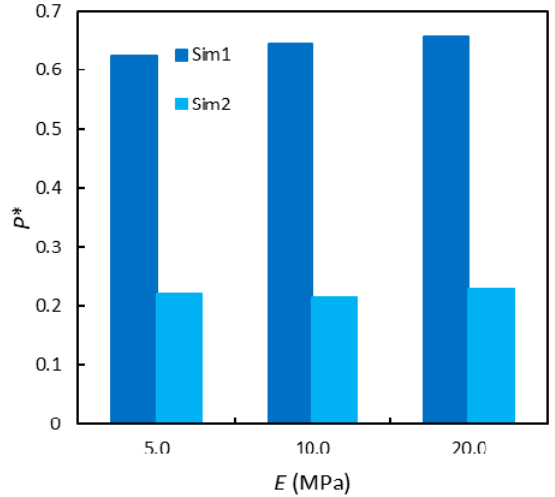
Figure 9. Pressure at the bottom of the column upon varying the Young modulus.